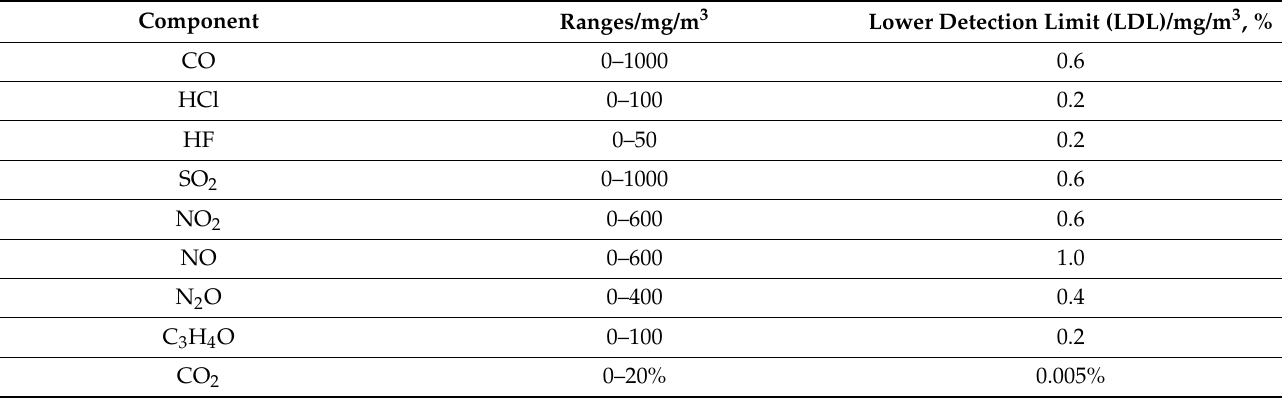
Table 2. Standard Analysis Model ranges for common emission